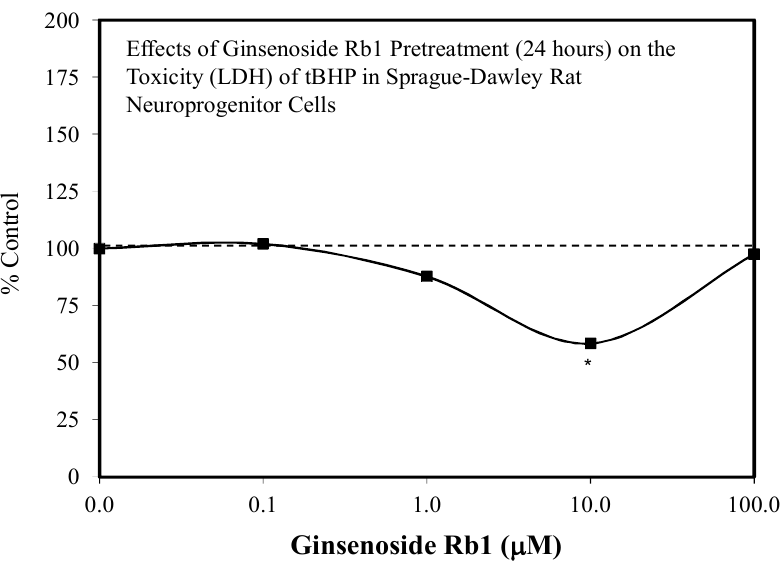
Figure 16. Effects of ginsenoside Rb1 pretreatment (24 h) on the toxicity (LDH) of tBHP in Sprague–Dawley rat neuroprogenitor cells (source: [69]). Each * represent statistical significance for a data point.